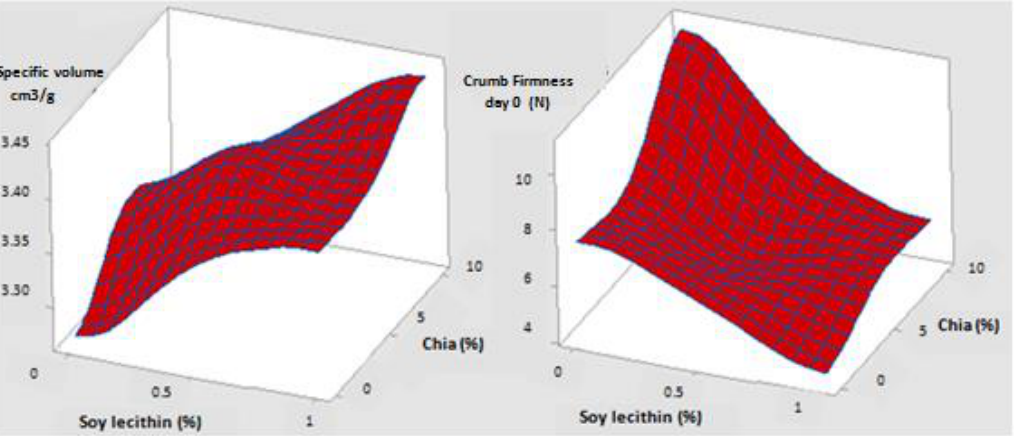
Figure 4. Response surfaces of crumb firmness (on the right) and specific volume (on the left) of fresh bread.